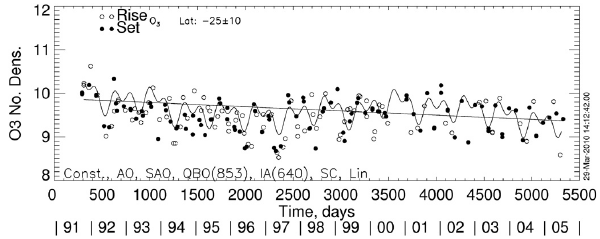
Fig. 2. Time series of bin-averaged, SAGE sunrise and sunset ozone number density measurements (in cm − 3 multiplied by 10 − 11 ) at 25 ◦ S and 37.5 km. Terms of the MLR model are indicated at the lower left, where SC refers to an 11-yr sinusoid term. The oscillat- ing solid curve is the model fit to the data, while the straight line curve is the sum of just the constant and linear trend